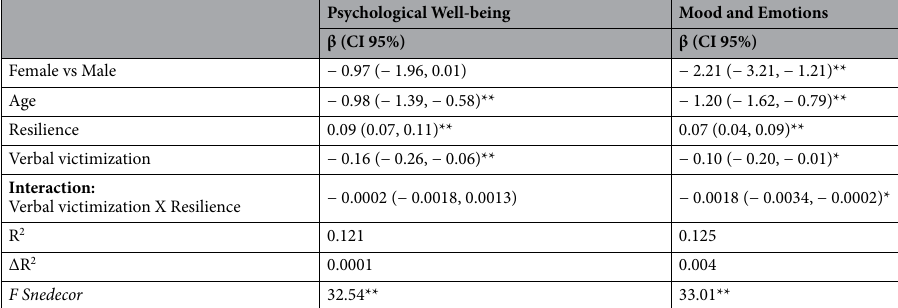
Table 5. Associations between psychological domains of HRQoL and resilience among adolescents exposed to verbal victimization. Associations between verbal victimization and resilience on psychological domains calculated by linear regression analyses expressed through β coefficients and 95% confidence intervals (CI 95%). * p < 0.05; ** p < 0.001.